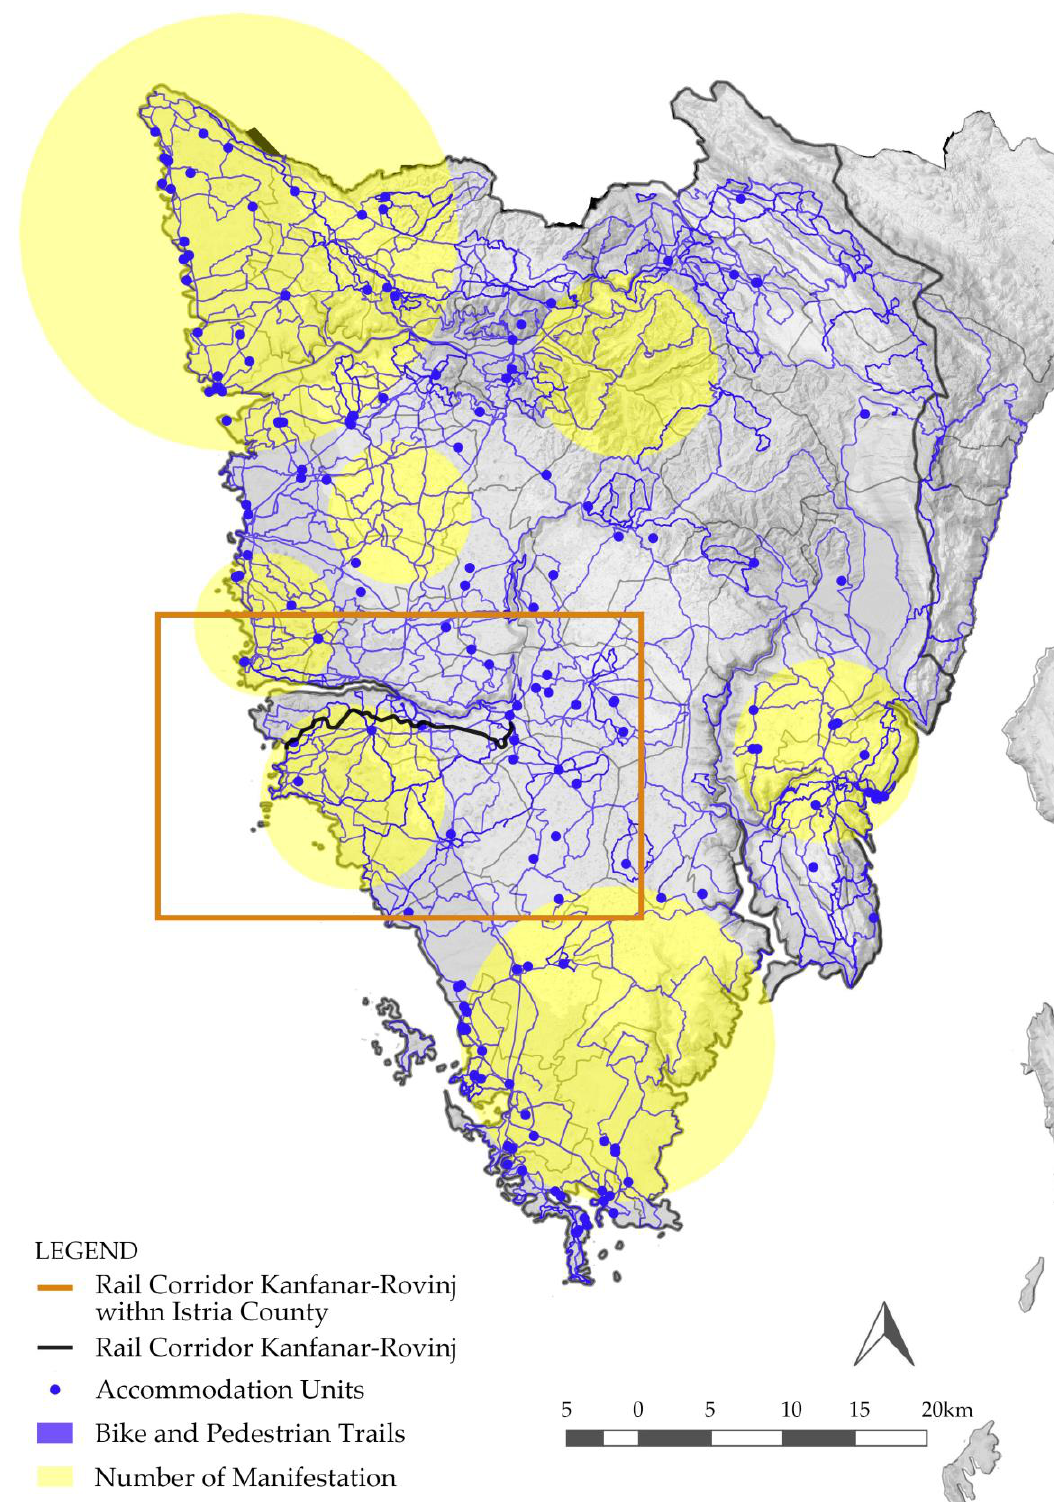
Figure 4. Bicycle and pedestrian trails, accommodation units, and events in Istria County.